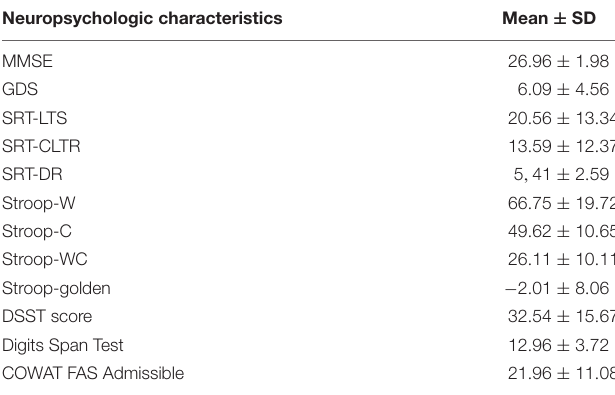
TABLE 1 | General characteristics of the study participants ( n = 104). TABLE 2 | Neuropsychological characterization of the study participants ( n = 104).